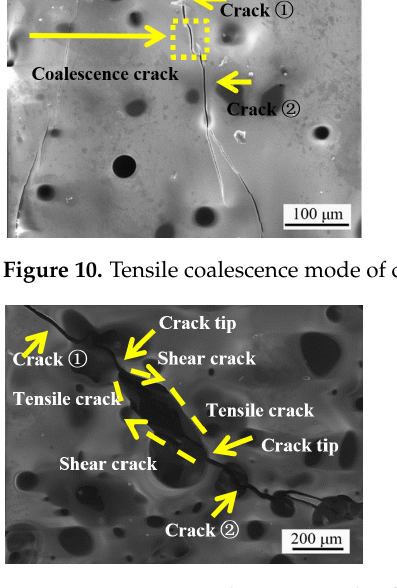
Figure 11. Mixture coalescence mode of crack coalescence.